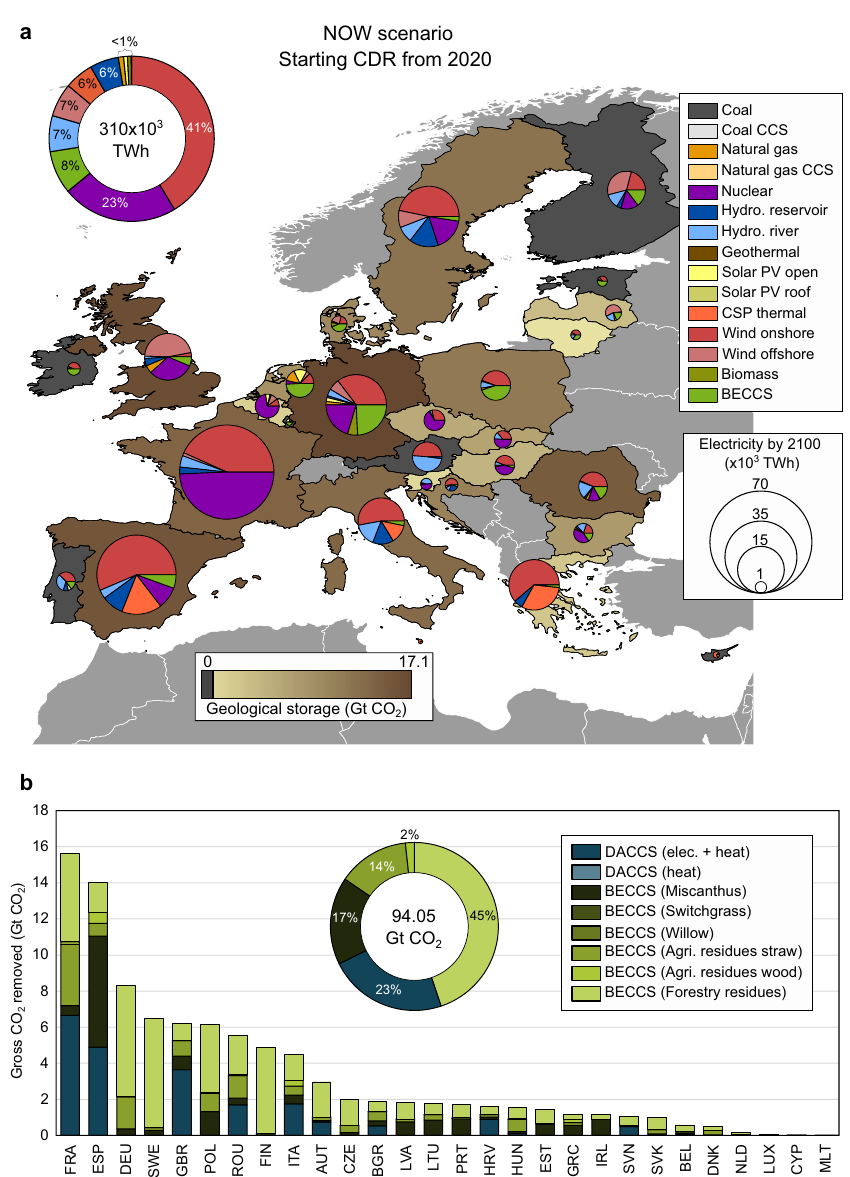
Fig. 3 Regional implications for the European energy system starting the deployment of bioenergy with carbon capture and storage (BECCS) and direct air carbon capture and storage (DACCS) in 2020 (NOW scenario). Subplot ( a ) corresponds to the optimal electricity generation by 2100 in each European country. The pie charts show the share of generation per electricity technology depicted with different colors, while the size of the pie charts is proportional to the generation by 2100 (TWh). CCS, PV and CSP stand for carbon capture and storage, solar photovoltaic and concentrated solar power, respectively. Each country is colored according to the CO 2 stored in the geological sites; the darker the shade, the greater the CO 2 stored. Subplot ( b ) shows the breakdown by country of the gross CO 2 removed from the atmosphere considering the different biomass resources for BECCS and DACCS technologies. Countries in subplot ( b ) are labeled according to the ISO3 code abbreviation. The map in subplot ( a ) was created using ArcGIS ® 10.7.1 software by Esri 82 ; no copyrighted material was